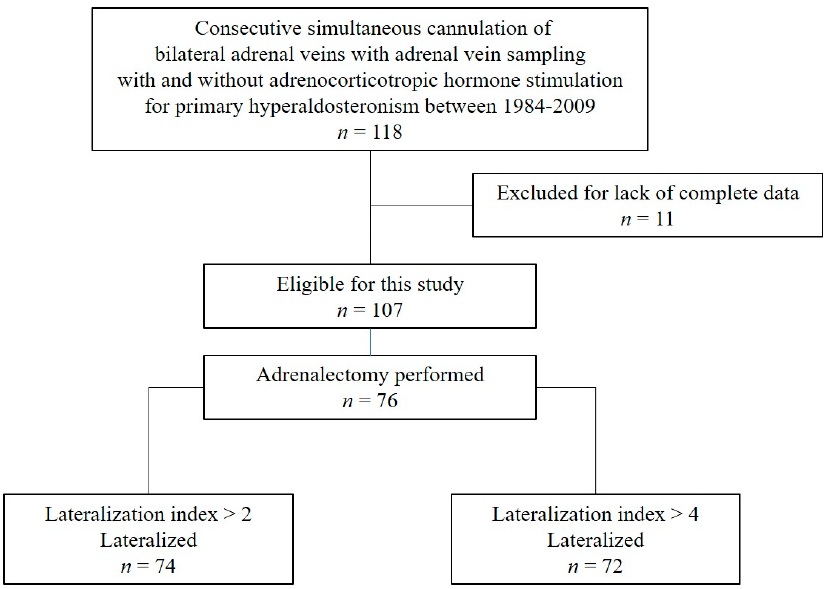
Figure 1. Selection of the study population.